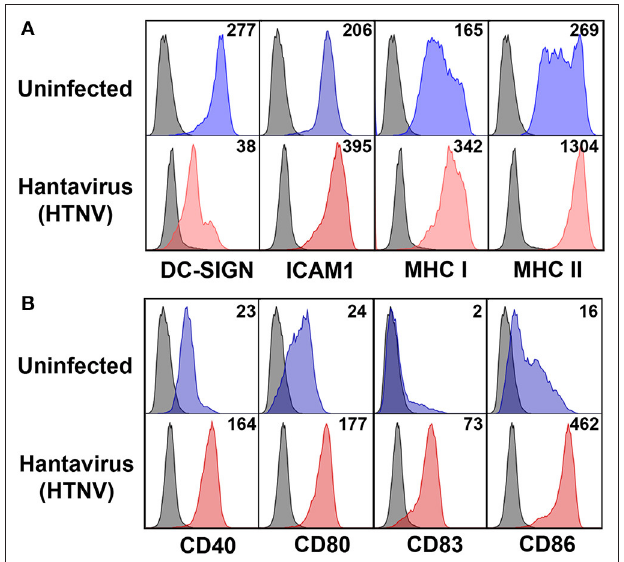
FIGURE 2 | Mature DC phenotype after hantavirus infection. Immature DCs were infected with HTNV at MOI of 1.5 and incubated for 4 days before staining for (A) maturation markers and (B) costimulatory markers. The results shown are representative of three independent experiments using three different donors.